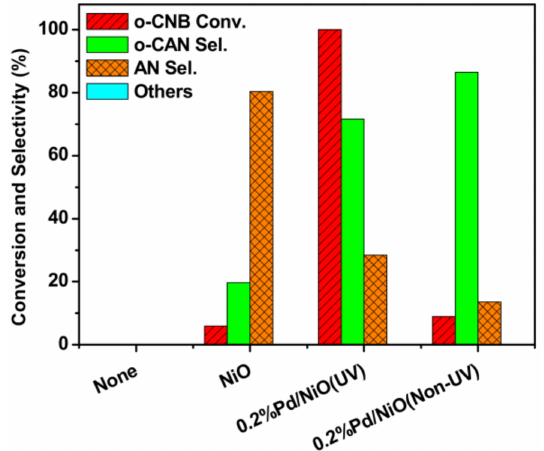
Figure 6. Catalytic hydrogenation of o -CNB in different catalytic systems. Conditions: 60 ◦ C, 0.5 h,